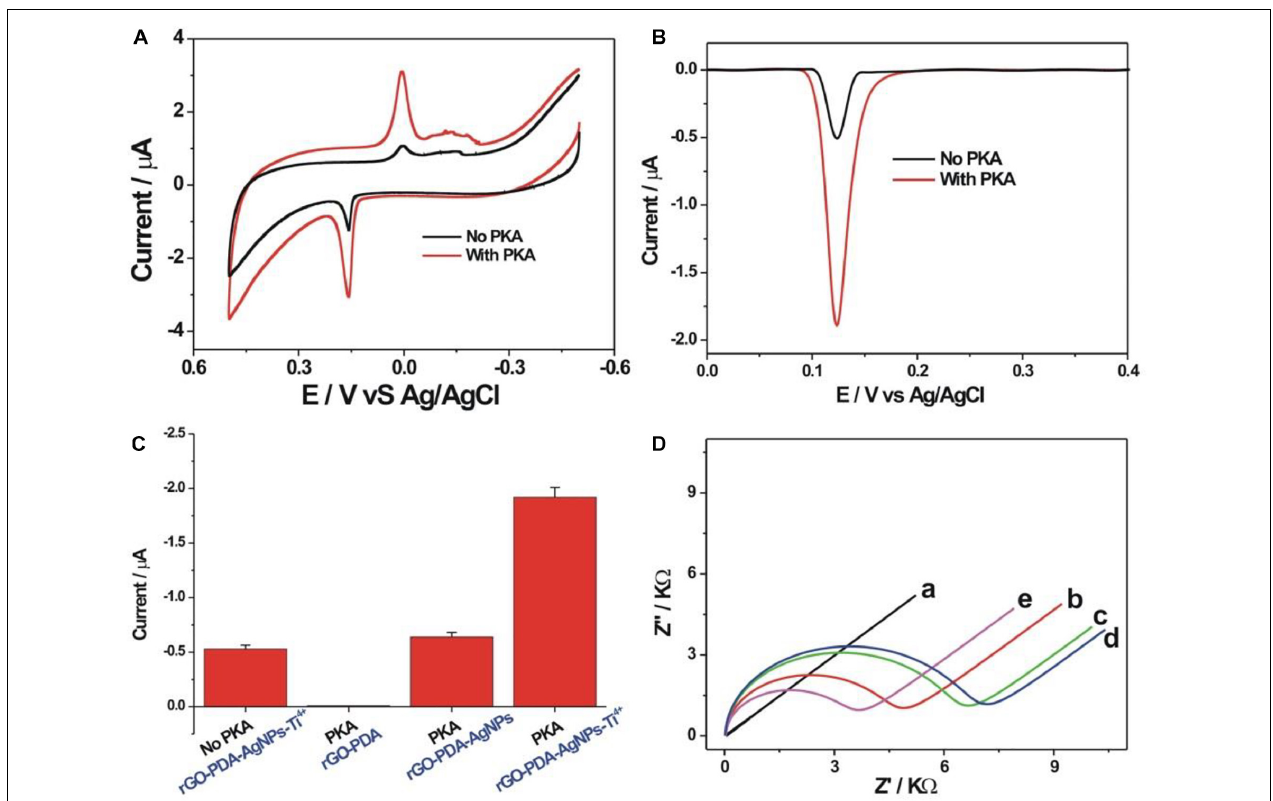
FIGURE 3 | Cyclic voltammetric (A) and differential pulse voltammetric (B) curves of the PKA biosensor toward blank (black curve) and 10 U/mL PKA (red curve) in 10 mM Tris-HCl (10 mM NaCl, pH 7.4). (C) Comparison of DPV responses toward 10 U/mL PKA obtained at different control conditions. The rGO-PDA and rGO-PDA-AgNPs were used as the substitutes of the rGO-PDA-AgNPs-Ti 4 + , respectively. (D) Electrochemical impedance spectroscopy for the differently assembled electrodes in 5 mM [Fe(CN) 6 ] 3 - / 4 - of 10 mM PBS buffer (pH 7.4, 1 M KCl) including the bare gold electrode (a), kemptide-immobilized electrode (b), after MCH blocking (c), phosphorylation of kemptide (d), and recognition with the rGO-PDA-AgNPs-Ti 4 + nanocomposite (e). EIS was operated with the frequency range from 0.1 Hz to 10 kHz and the amplitude of 5